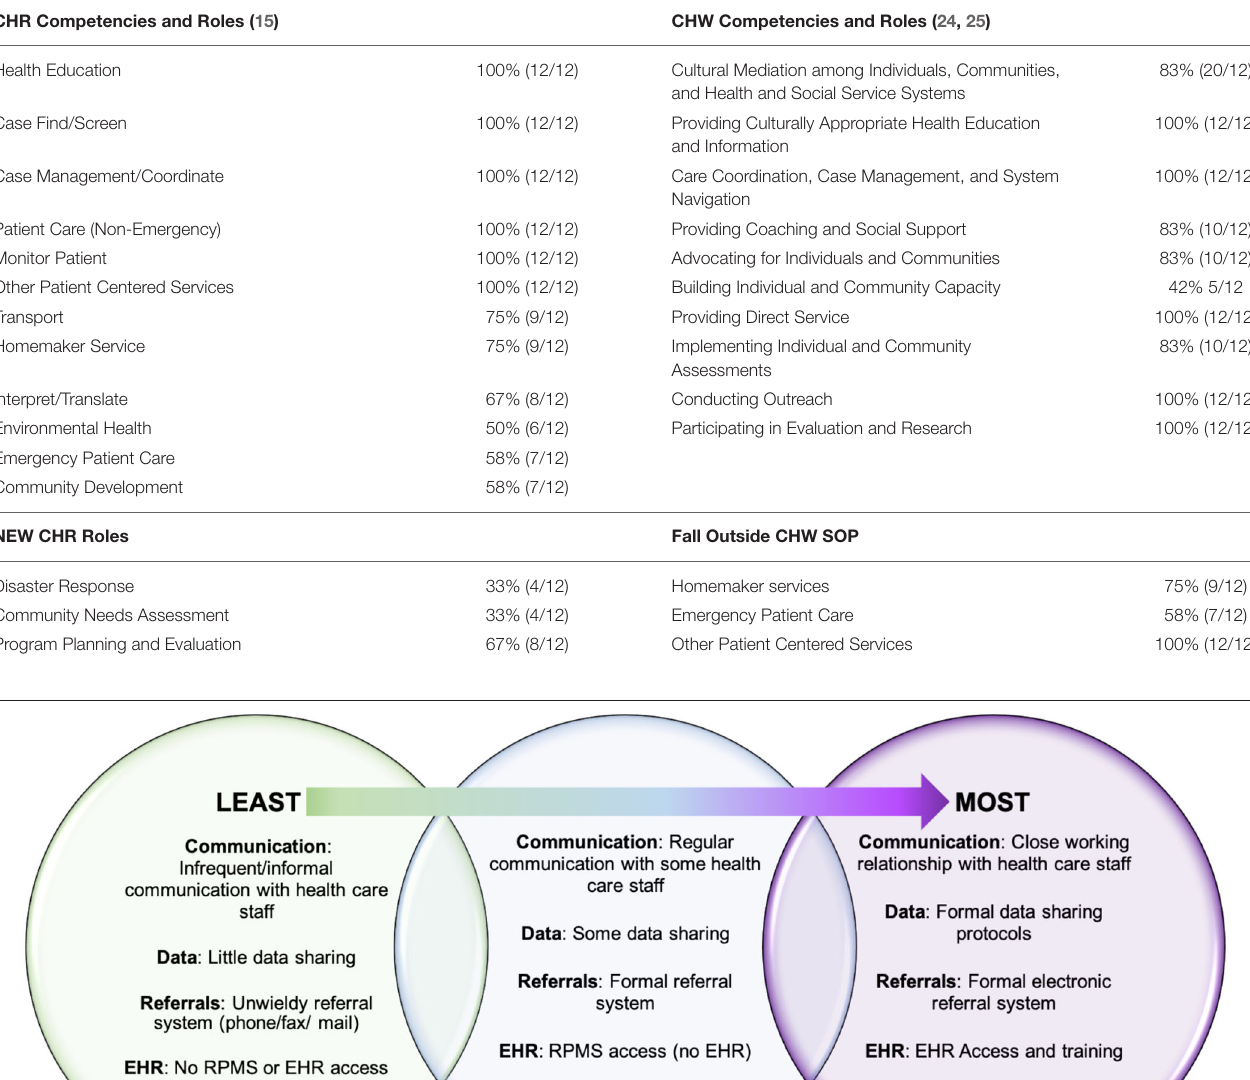
TABLE 3 | CHR core roles and competencies by Indian Health Service and CHW Core Consensus Project. CHR Competencies and Roles (15)